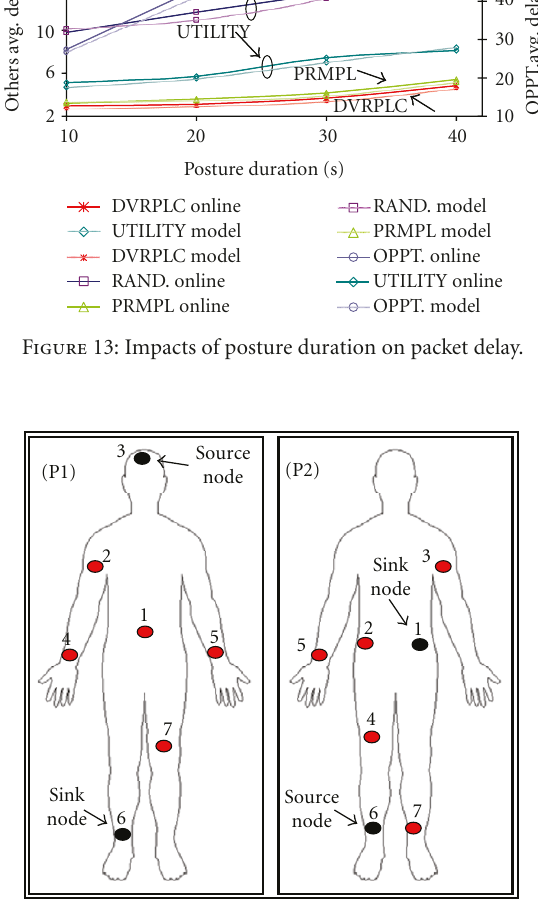
Figure 14: Experiments with di ff erent sensor